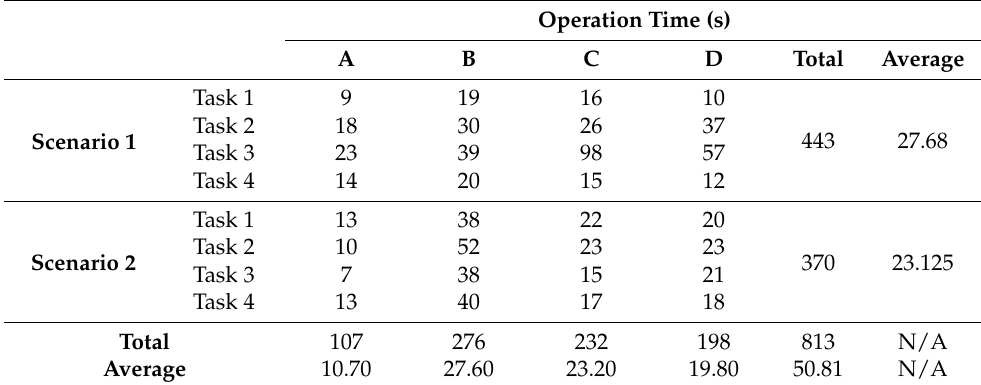
Table 8. Field test results for Method 3.